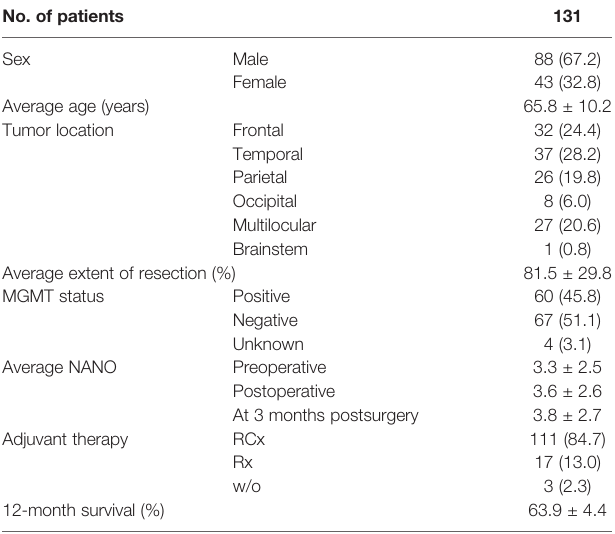
TABLE 1 | Baseline